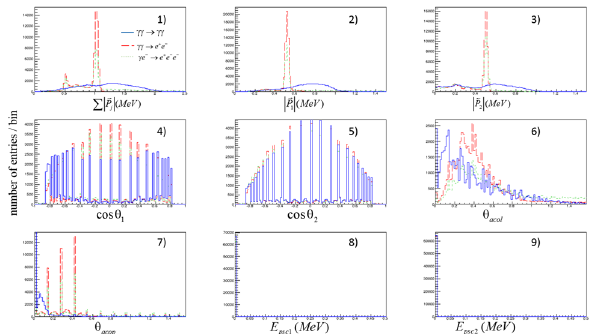
Fig. 7 Distributions of observables used for the analysis, signal (blue- solid), γγ → e + , e − (red, dashed), and γ e − → e + e − e − (green-dots). Forvisualizationpurposes,thenumberofentriesineachfigureisaresult of 100 k simulated events and does not represent the expected number of events in the experiment. The numbers on each panel correspond to definitions of valuables in the